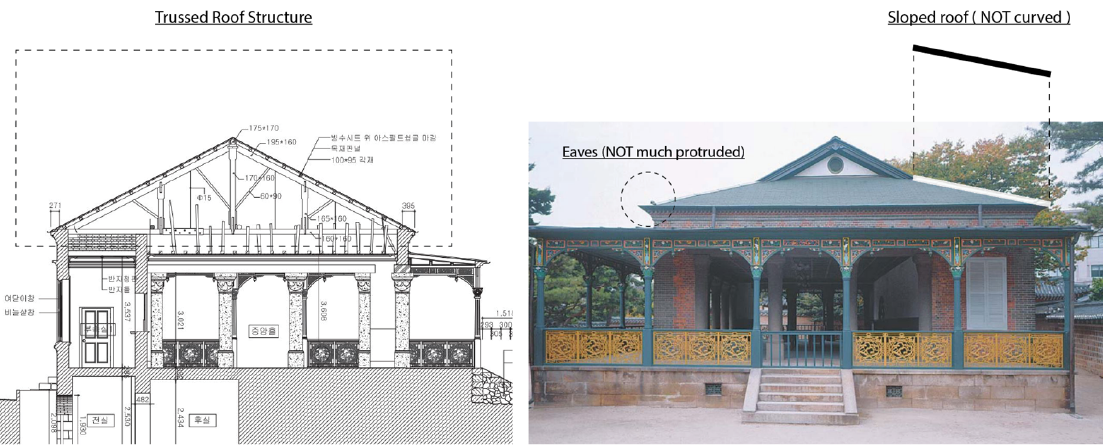
Figure 4. Jeonggwanheon Hall in Deoksugung Palace: ( Left ) Section Drawing ( Right ) Exterior.